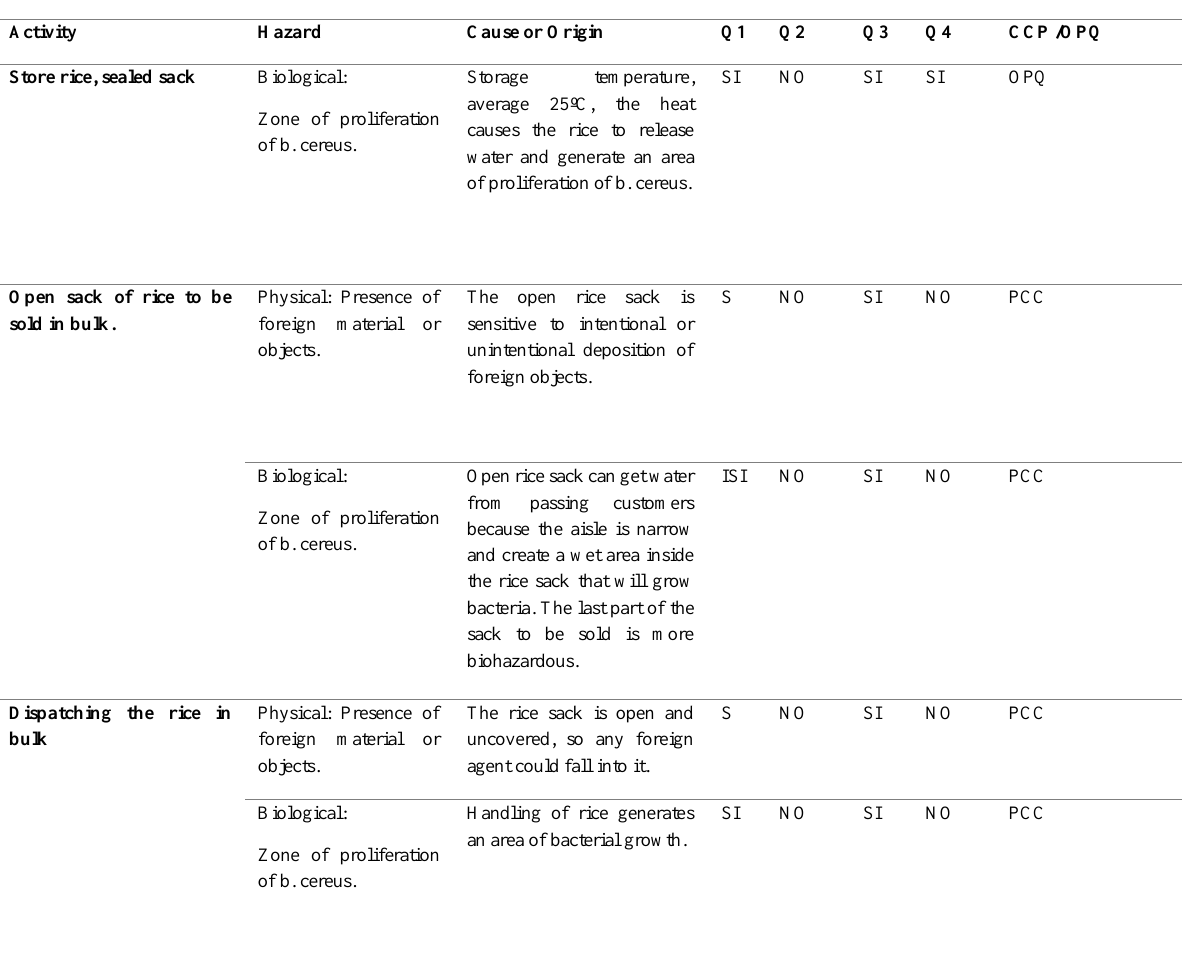
Table 4: Determination of